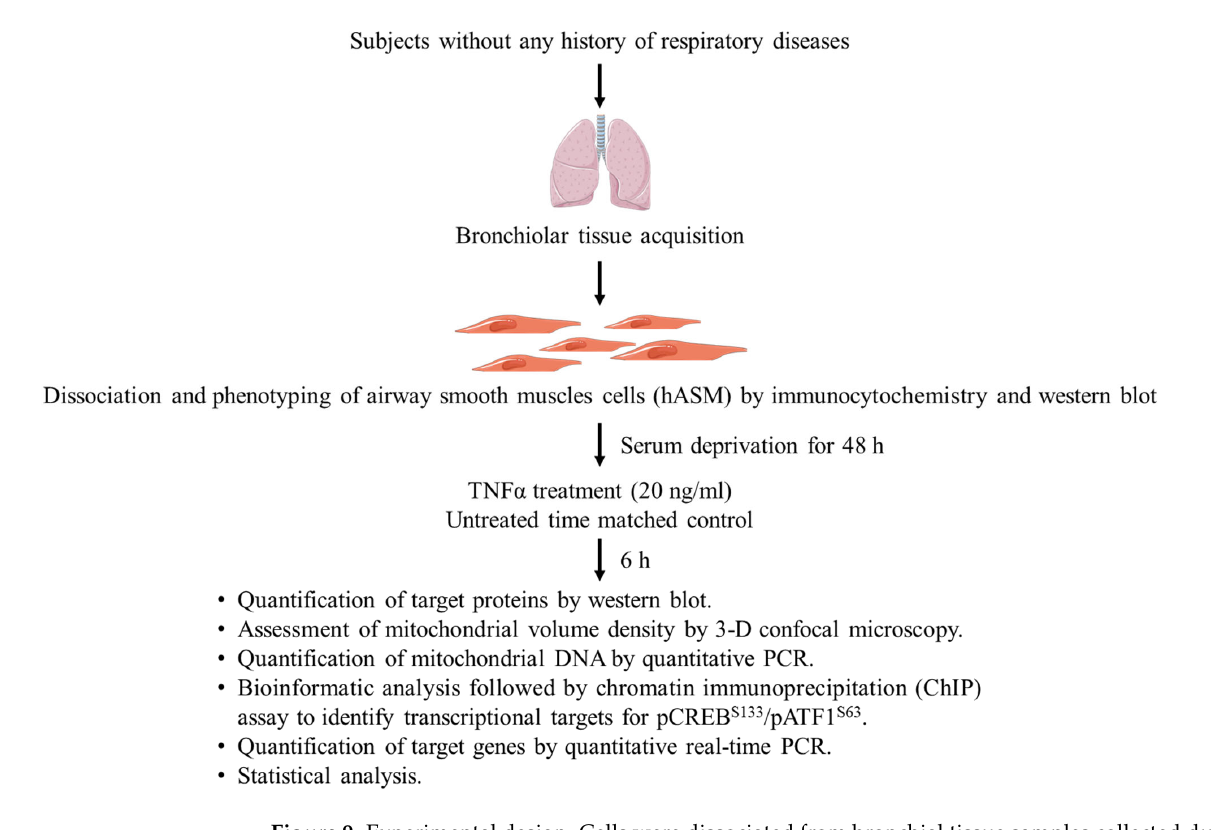
Figure 9. Experimental design. Cells were dissociated from bronchial tissue samples collected during surgery from anonymized female and male patients without any history of respiratory diseases. The hASM phenotype of dissociated cells was confirmed by the expression of alpha-smooth muscle actin ( α -SMA) via immunocytochemistry (ICC; cellular analysis) and Western blot (homogenate protein analysis). Dissociated hASM cells from each of six patients undergoing lung surgery (without history of airway diseases or recent smoking) were divided into two experimental groups: (1) treated with TNF α (20 ng/mL for 6 h), or (2) untreated time-matched controls. Mitochondria in hASM cells were labeled using MitoTracker Green and imaged in 3D by confocal microscopy. Protein expression in homogenate samples were analyzed by Western